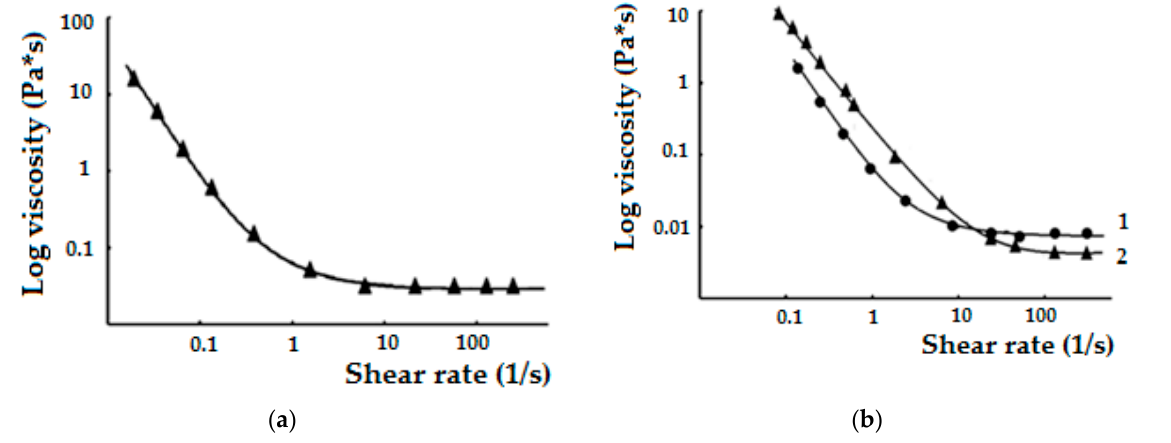
Figure 4. Viscosity as a function of shear rate for polymers, dissolved in saline solution: ( a ) chitosan hydrochloride (conc. 8%) or ( b ) pectin (conc. 2%): 1—apple; 2—citrus. Data are expressed as mean ± SD; n = 3.